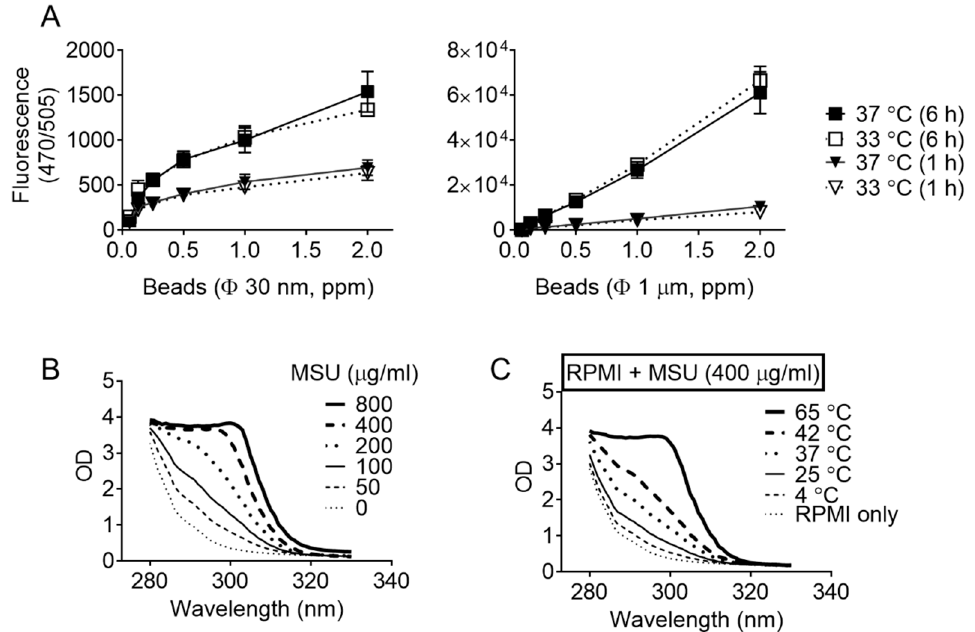
Figure 5. Effects of temperature on phagocytosis and MSU solubility. ( A ) BMDMs were incubated with increasing con- centrations of beads at 33 or 37 °C for 1 or 6 h. The phagocytosis rate was analyzed by the fluorescence units inside the cells. ( B ) An increasing concentration of MSU was dissolved in DW and measured OD from 280 to 330 nm. ( C ) MSU (400 µ g/mL) was added in PRMI 1640 and incubated at the indicated temperature for 3 h. After eliminating the crystals by filtration, the RPMI 1640 was measured OD from 280 to 330 nm. The graphs present the mean ± standard deviation (SD), and B and C graphs shows the mean of at least two independent